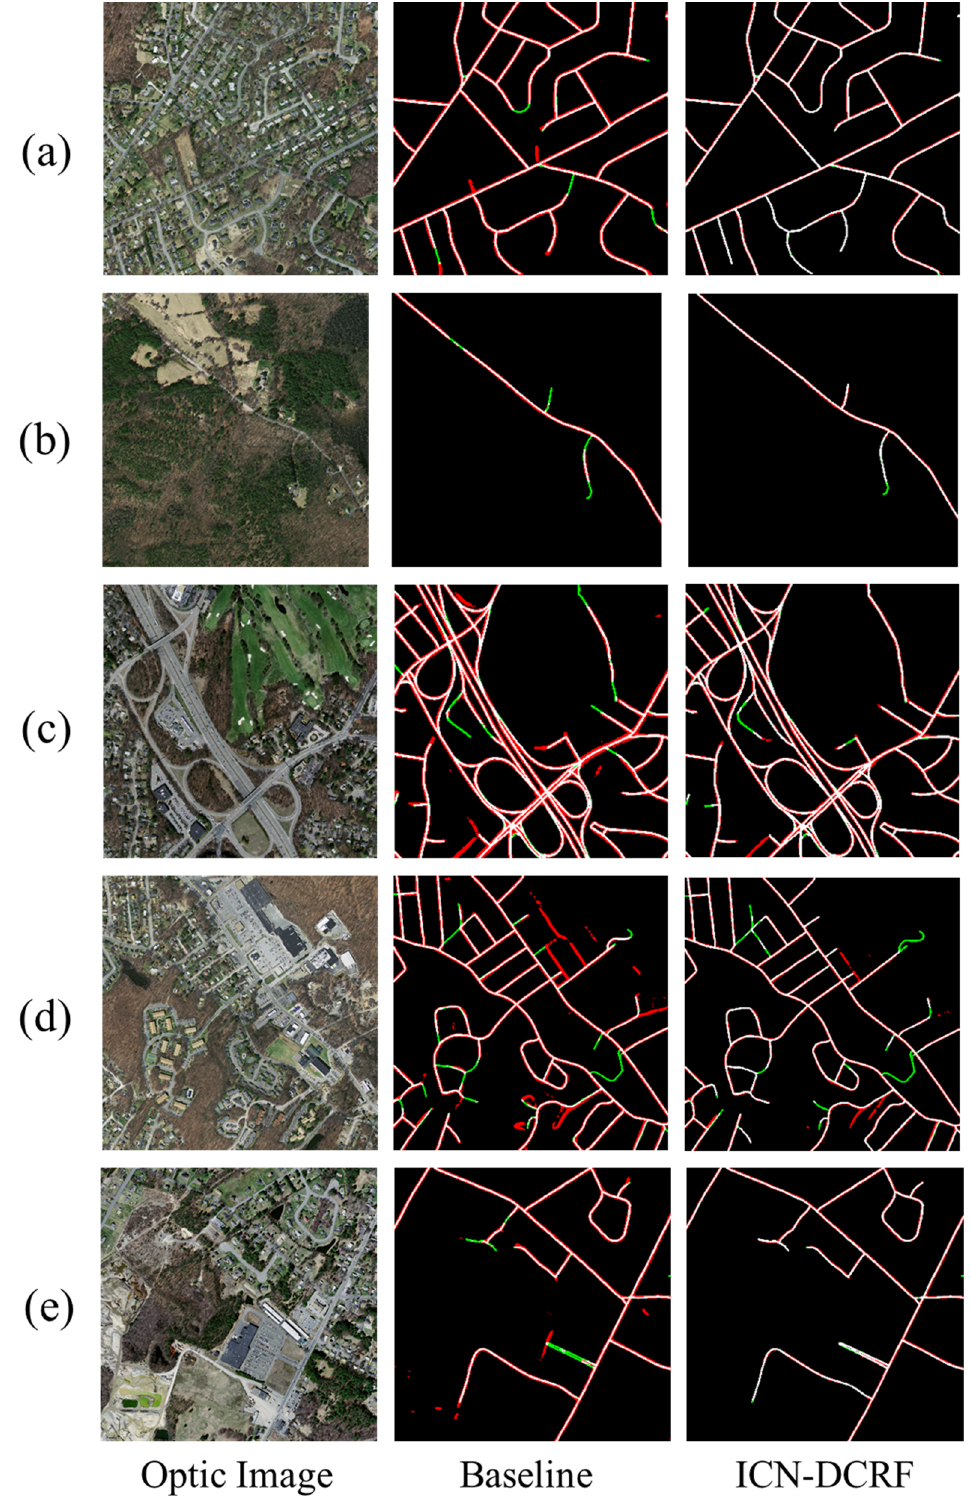
Figure 6. Error analysis of the proposed model. White pixels denote the road area that is detected correctly (TP), red pixels denote the background area which is detected as roads (FP), and green pixels denote the road area which is detected as background (FN). For each row in ( a – e ), it contains an optic image, and two result maps of a sample region.